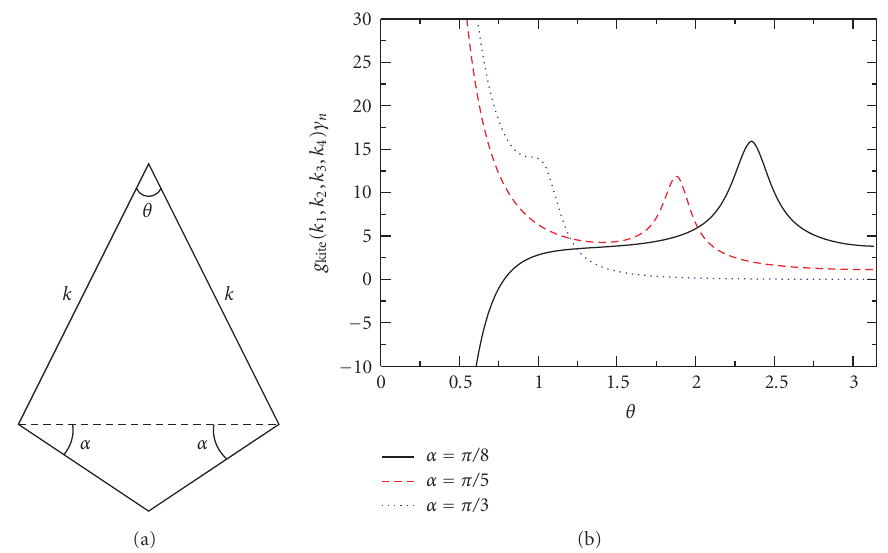
Figure 20: Trispectrum geometrical factor for the kite quadrilaterals (represented on the left panel) as a function of the opening angle θ , and plotted for various values of α . The trispectrum is enhanced in the squeezed limit θ → 0. The bump for θ p = π − 2 α corresponds to the parallelogram limit for which the unconnected part is no longer